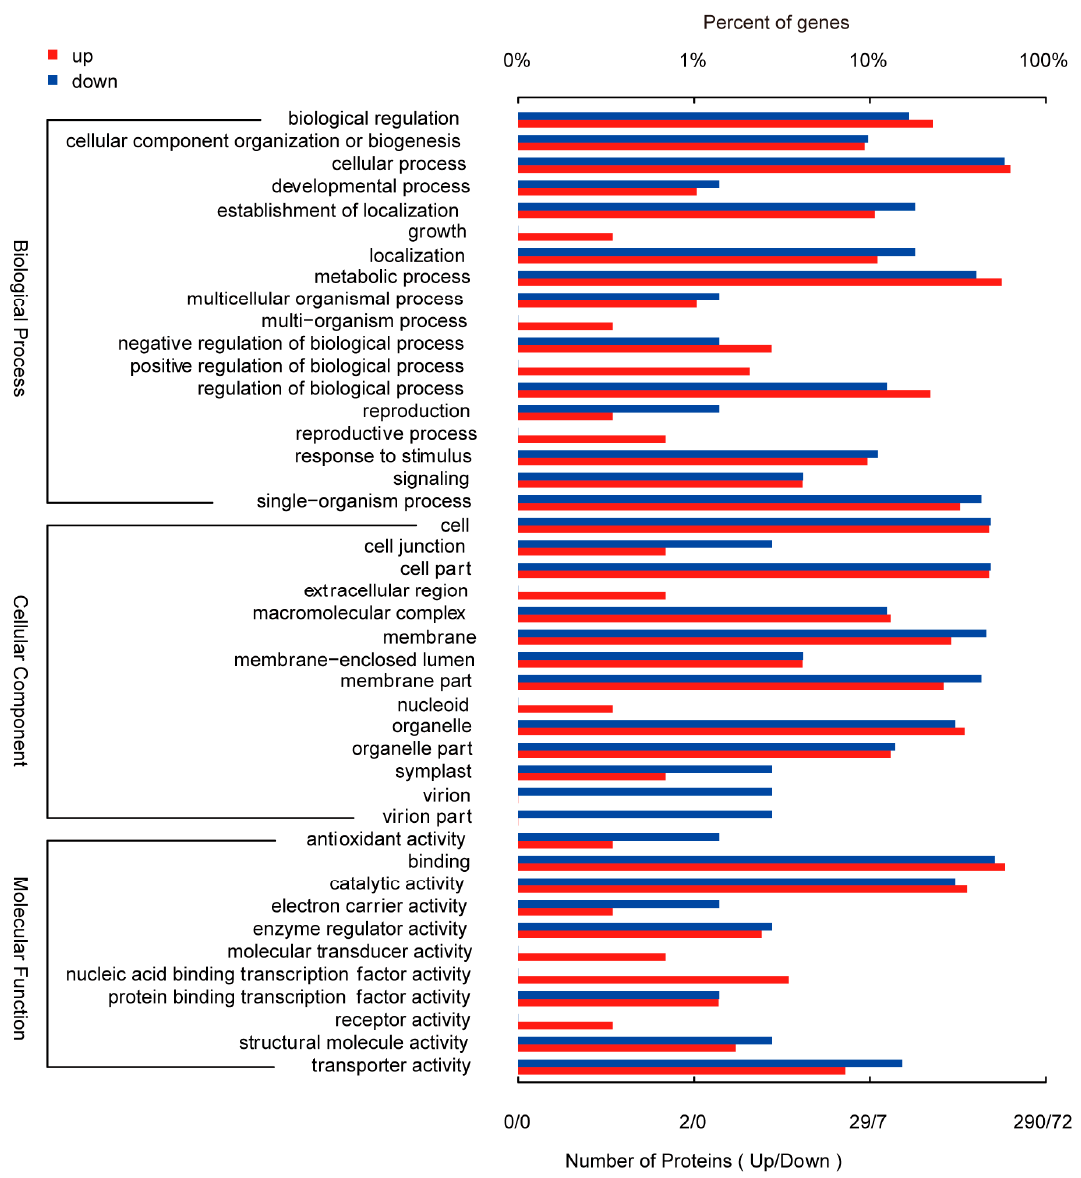
Figure 5. Gene ontology analysis of the set of differentially phosphorylated proteins. The red and blue bars represent proteins which were, respectively, increased and decreased in abundance by exposure to Cd stress.